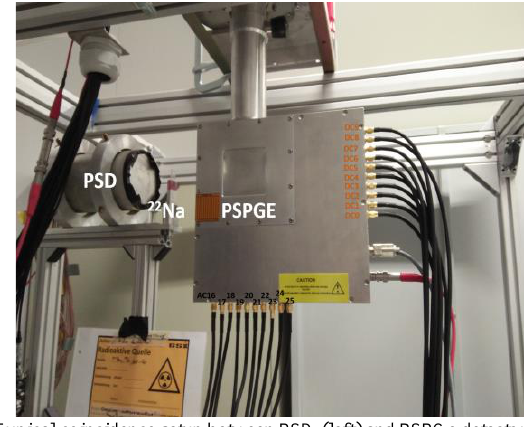
Fig. 1: Typical coincidence setup between PSD (left) and PSPGe detector (right) (DC and AC strips are marked in orange and blue color, respectively).